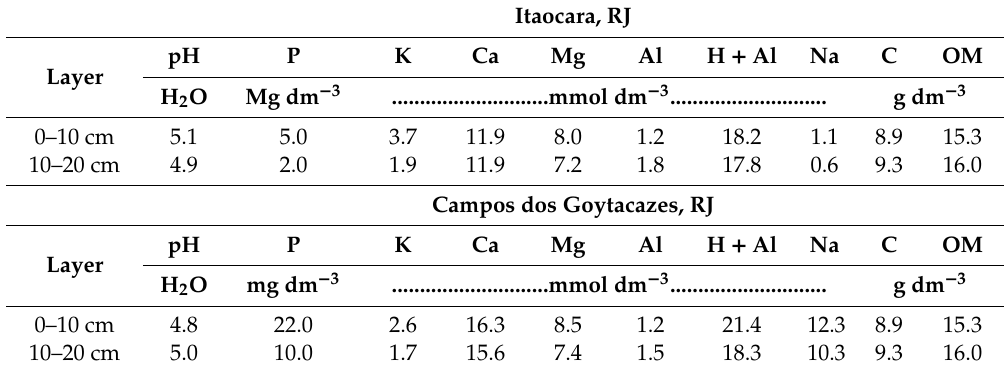
Table 1. Soil chemical properties of experimental areas in Itaocara and Campos dos Goytacazes, in the layers 0–10 and 10–20 cm. OM: organic matter.